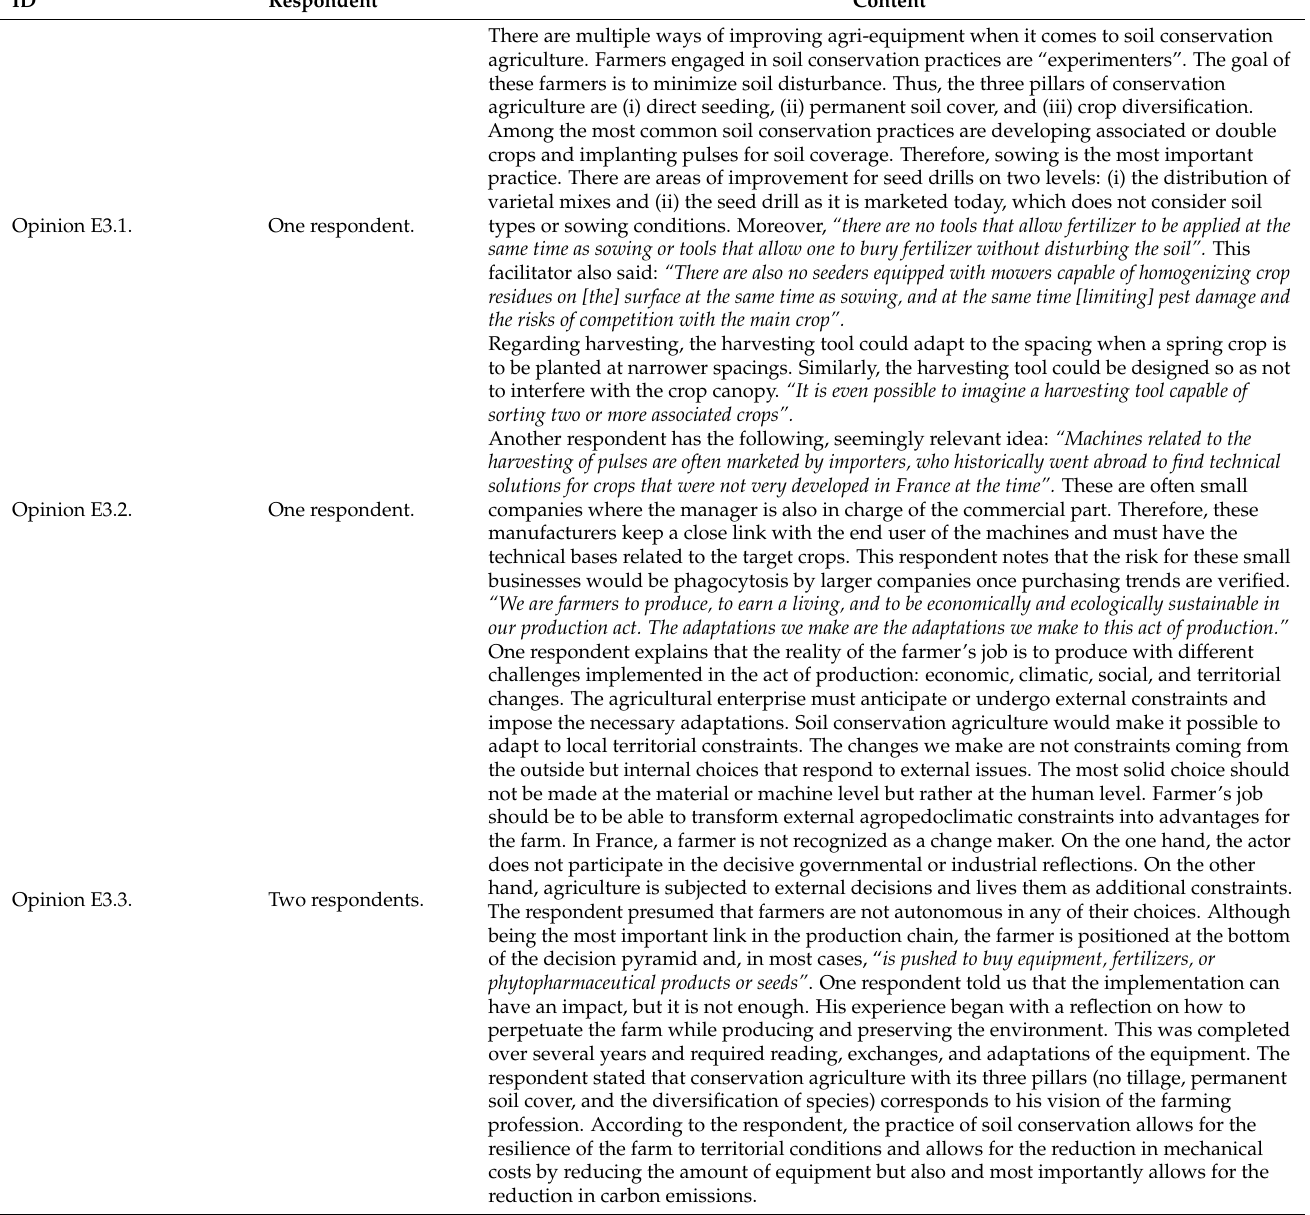
Table 5. Respondents’ opinions concerning pulses requiring specific equipment. Quotes from the respondents are reported in